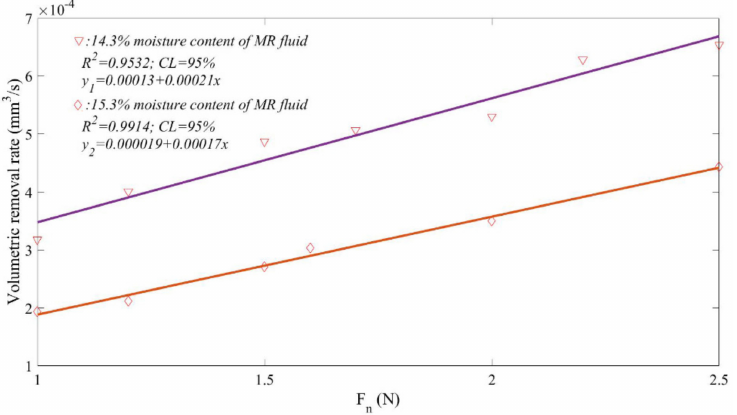
Figure 12. Volumetric removal rate and normal force with the moistures of MR fluid 14.3% and 15.3%. The removal effect before and after constant force control on a 200 mm × 200 mm × 10 mm fused silicon mirror is analyzed using uniform polishing. The six-axis robot drives the polishing head to maintain the normal contact with the workpiece and processes the whole workpiece surface under 14.3% moisture of MRF fluid. The polishing path is faster with 0.8 mm path pitch and the feed rate keeps constant. Figure 13a,b respectively shows the distributions of the normal polishing force and material removal amount without constant force control. From those, before compensation, the robot motion error causes uneven polishing at each point of the workpiece, and the material removal distribution is essentially the same as the normal force error distribution.